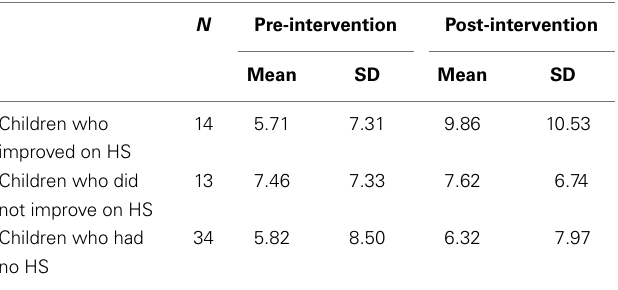
Table 5 | Hearing sensitivity (HS) and total number of shares ( N , mean, and SD)